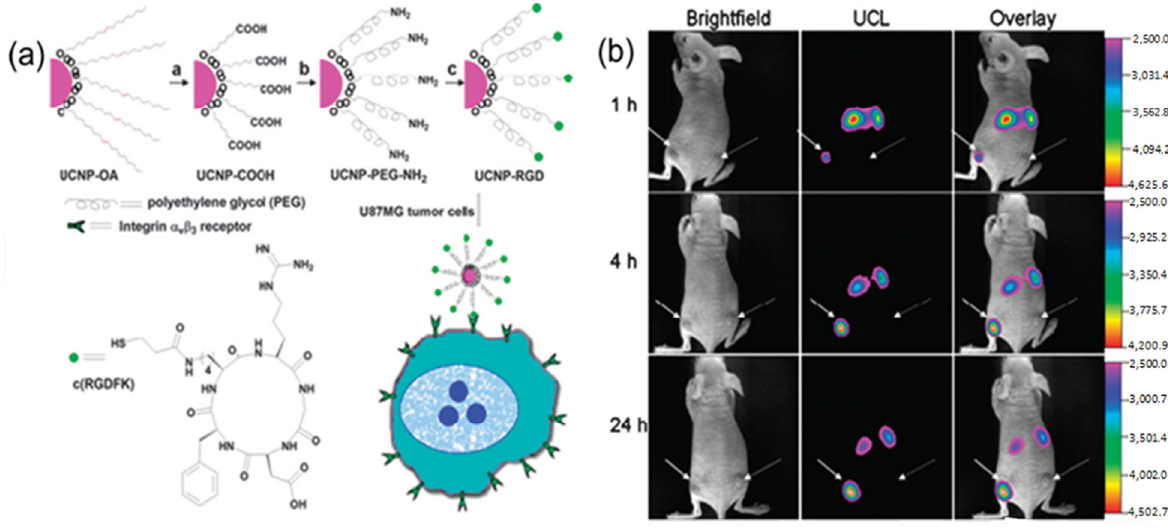
Figure 6. ( a ) Scheme of the synthesis of UCNP-Arginine-Glycine-Asparatic (RGD). ( b ) Time-dependent in vivo upconversion luminescence imaging of subcutaneous U87 MG (left hind leg, indicated by short arrows) and MCF-7 (Michigan Cancer Foundation-7) tumor (right hind leg, indicated by long arrows) borne by athymic nude mice after intravenous injection of UCNP-RGD over a 24 h period. UCNP-RGD conjugate was prepared from UCNP-OA complex (OA: Oleylamine). All images were acquired under the same instrumental conditions (power ≈ 80 mW cm -2 and temperature ≈ 21.5 °C on the surface of the mouse). Adapted with permission from reference [92]. Copyright: American Chemical Society,